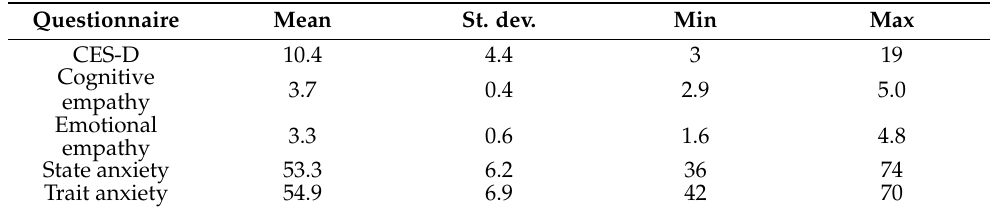
Table 3. Questionnaire scores.